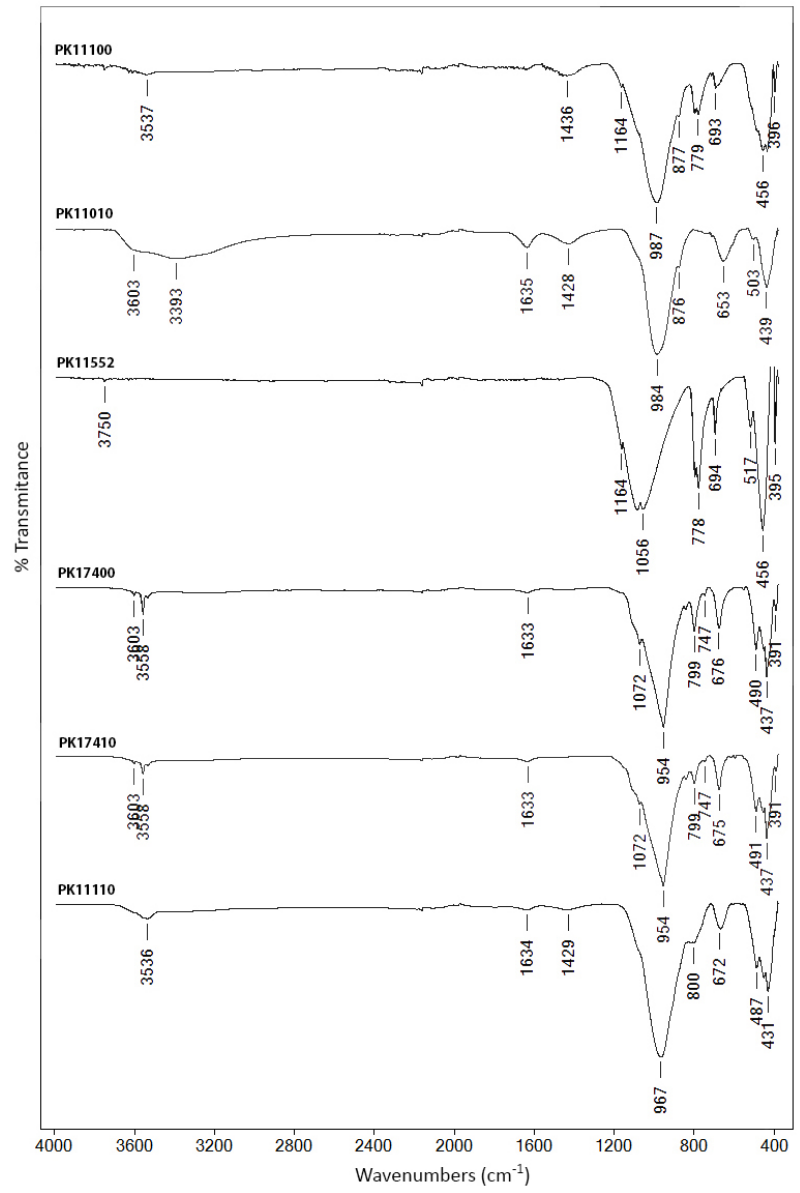
Figure 4. FTIR spectra registered on the green earth pigments.